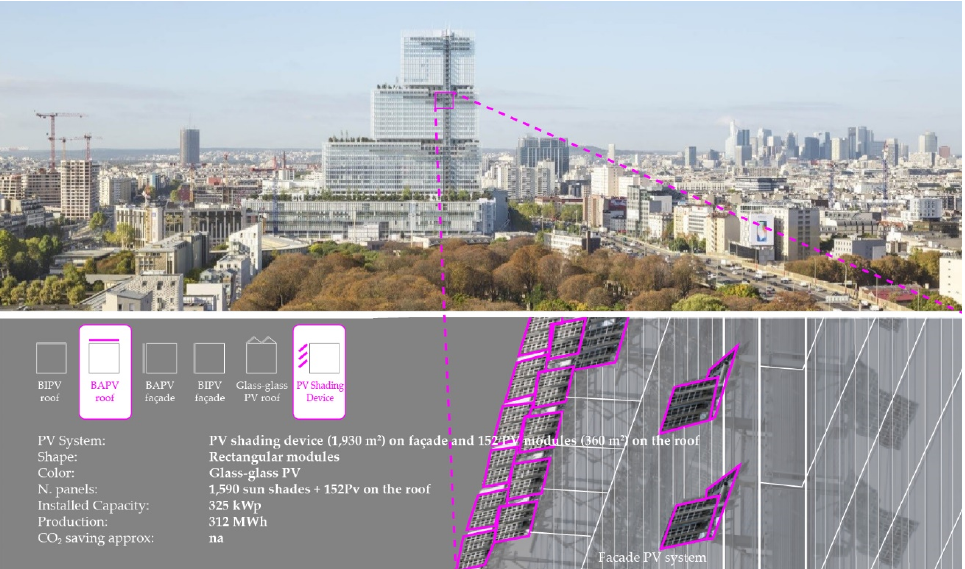
Figure 9. Paris Courthouse east façade (photography with permission of author Sergio Grazia) ( on the top ); Integration and characteristic of PV systems ( on the bottom ).